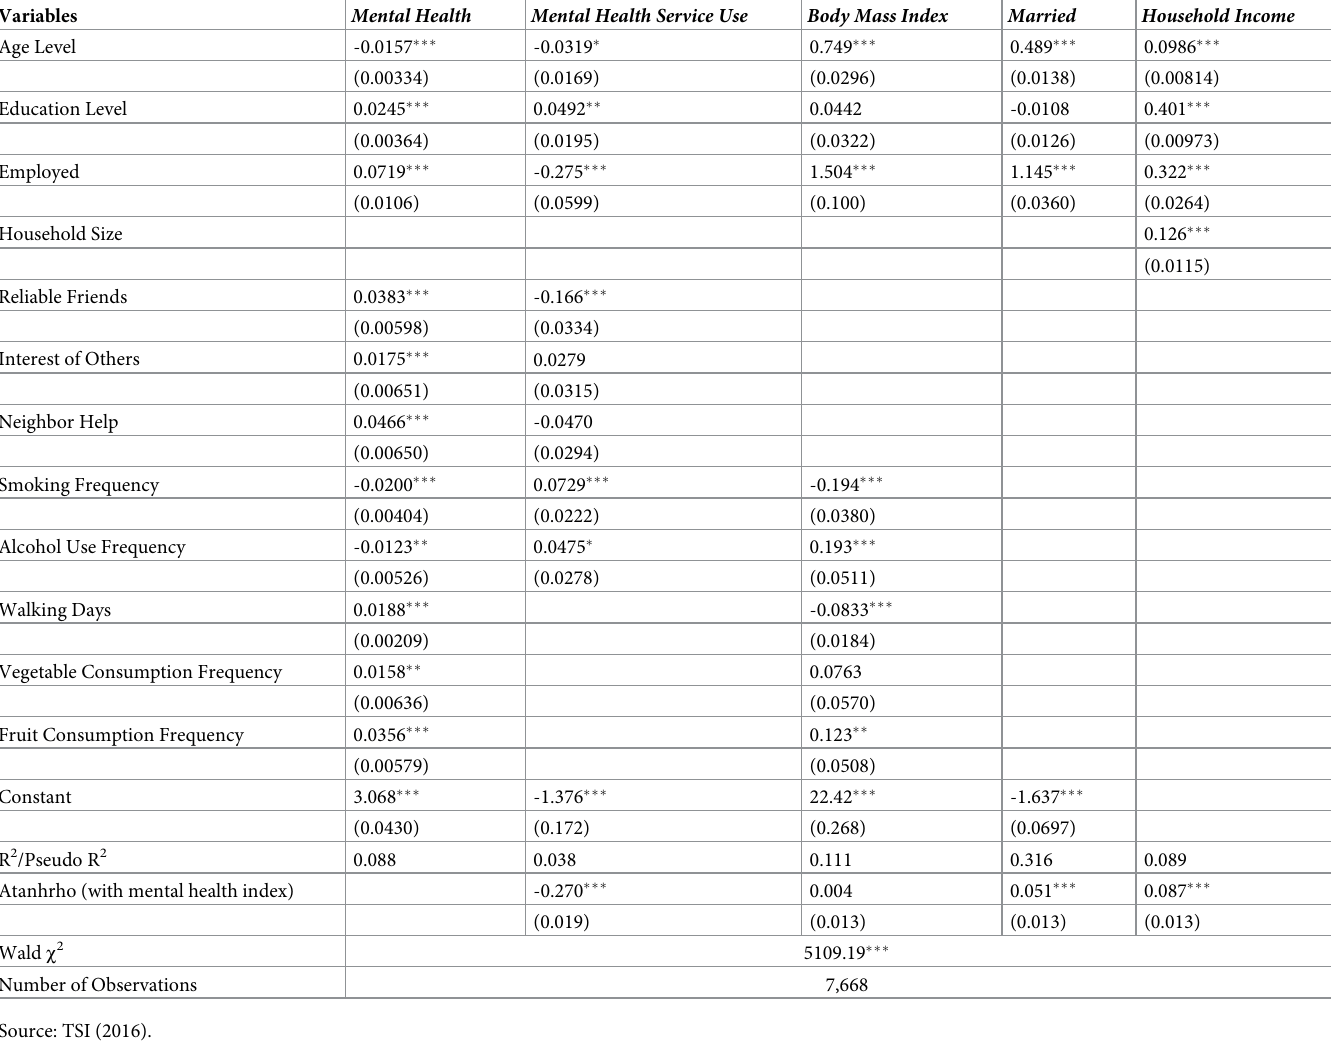
Table 6. CMP estimation results for mental health and income: Male